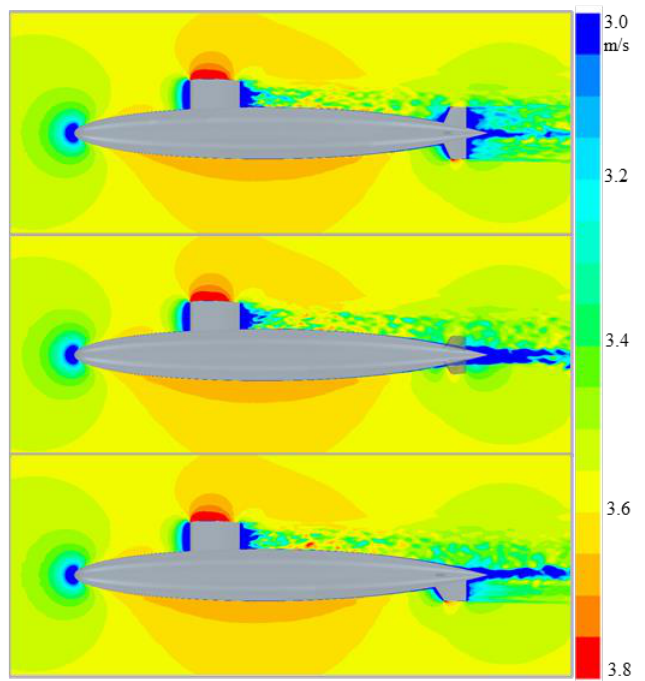
Figure 15. Velocity field in longitudinal section of an underwater vehicle with full appendages.